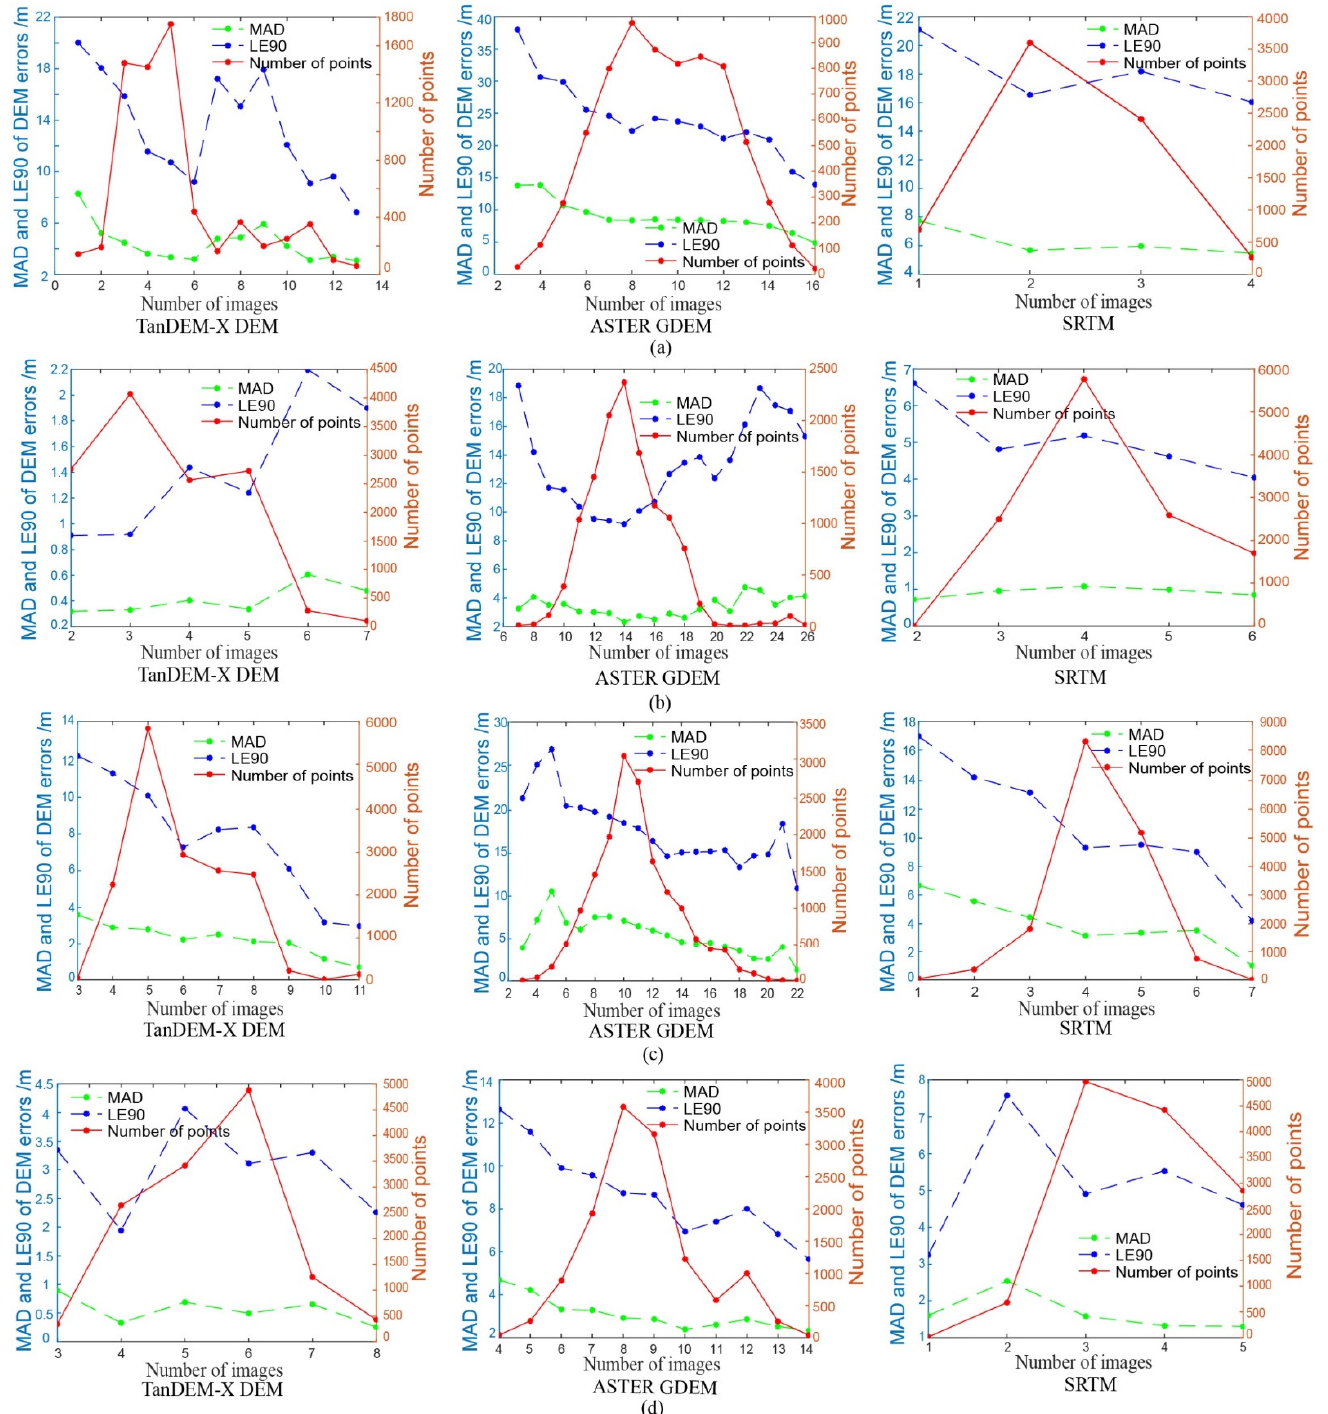
Figure 11. MAD and LE90 of the DEM errors versus the number of images used in the fusion process for TanDEM-X DEM, ASTER GDEM and SRTM in four study areas: ( a ) Sichuan; ( b ) Xinjiang A; ( c ) Xinjiang B; and ( d ) Inner Mongolia. The number of points contained under each image number is also shown as a separate curve.